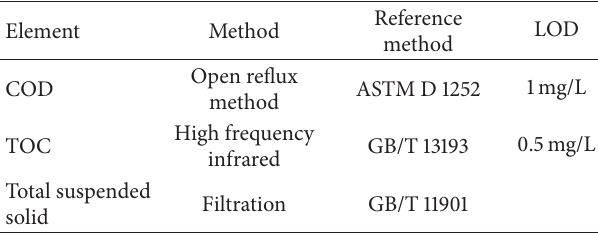
Table 2: Analysis method of organic matter.